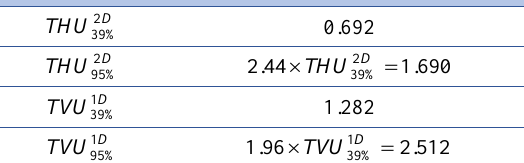
Table 2. Summary Statistics of the Low-cost Single-frequency